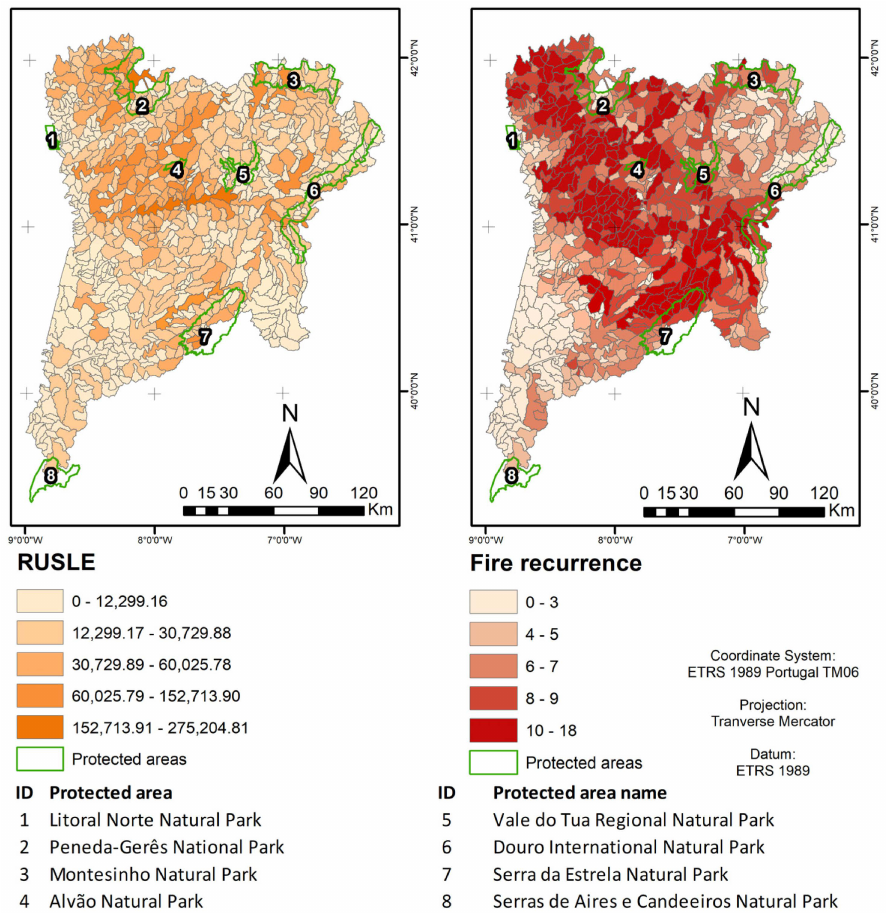
Figure 4. Relationship between RUSLE and Fire Recurrence values. The sub-watersheds (n = 671) recorded a mean of 15,737.07t ha − 1 yr − 1 soil loss. The sub-watersheds of the Douro River are located in an embedded valley with a high slope and sectors of Cenozoic sedimentary cover [64]. This characteristic favors erosive processes in this area, recording values above 152,713.91 t ha − 1 yr − 1 . North of the Douro River, the sub-basins of the protected areas (PAs) of Alv ã o (ID 4) and Peneda-Ger ê s (ID 2) record values higher than 60,025.79 t ha − 1 yr − 1 . Similar values occur in the sub-watersheds near the Serra da Estrela PA (ID